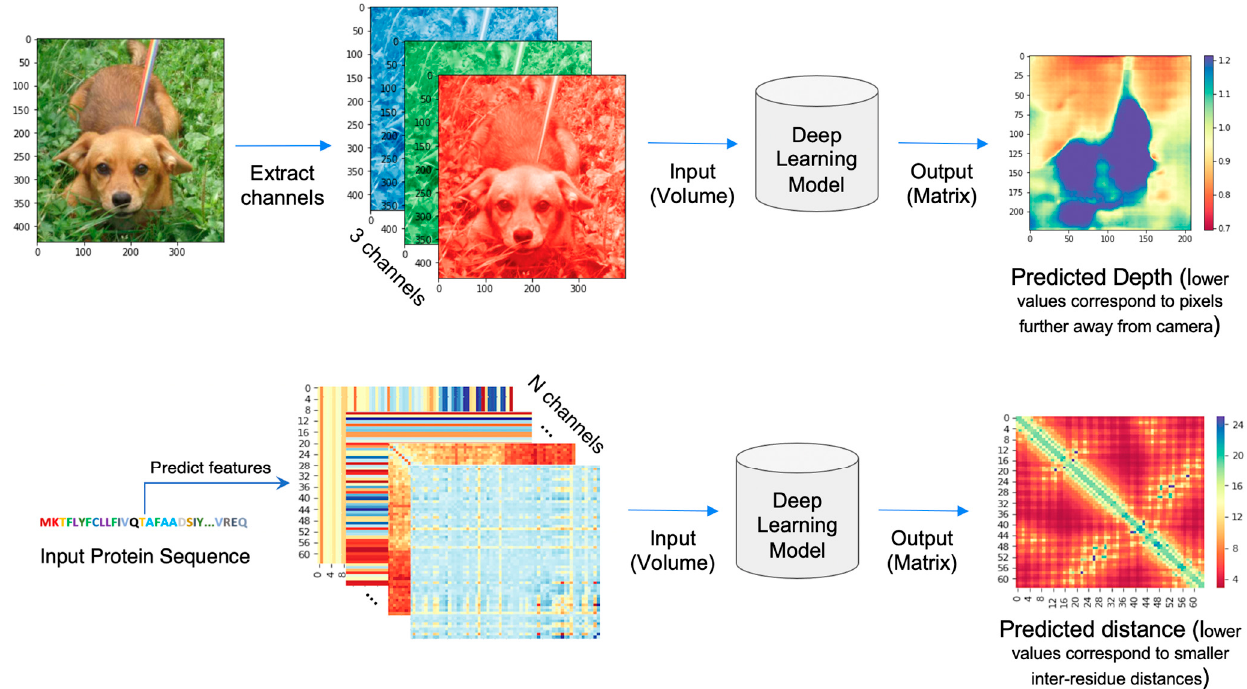
Figure 3. From the perspective of Deep Learning method development, the problem of protein distogram or real-valued distance prediction (bottom row) is similar to the ‘depth prediction problem’ in computer vision (top row). In all these problems, the input to the Deep Learning model is a volume (3D tensor). In case of computer vision, 2D images expand as a volume because of the RGB or HSV channels. Similarly, in the case of distance prediction, predicted 1D and 2D features are transformed and packed into 3D volume with many channels of inter-residue information.